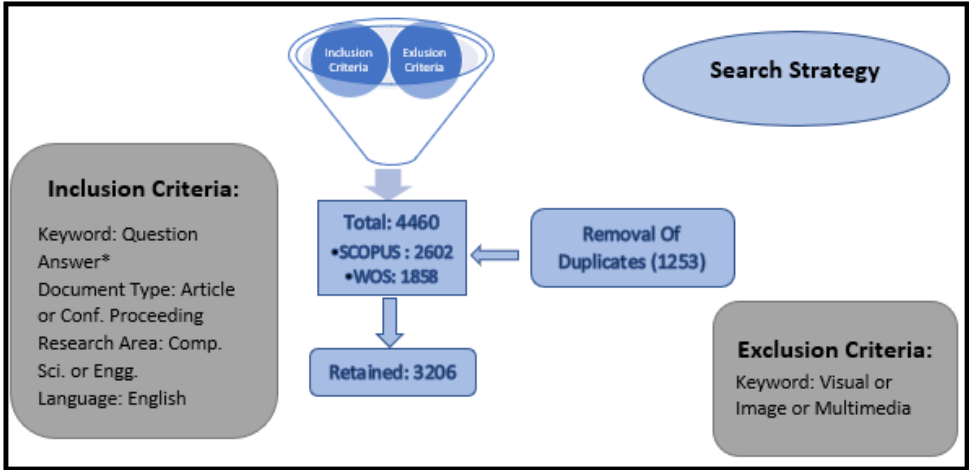
Figure 4. Search Strategy. * is wild card used to represent any or no group of